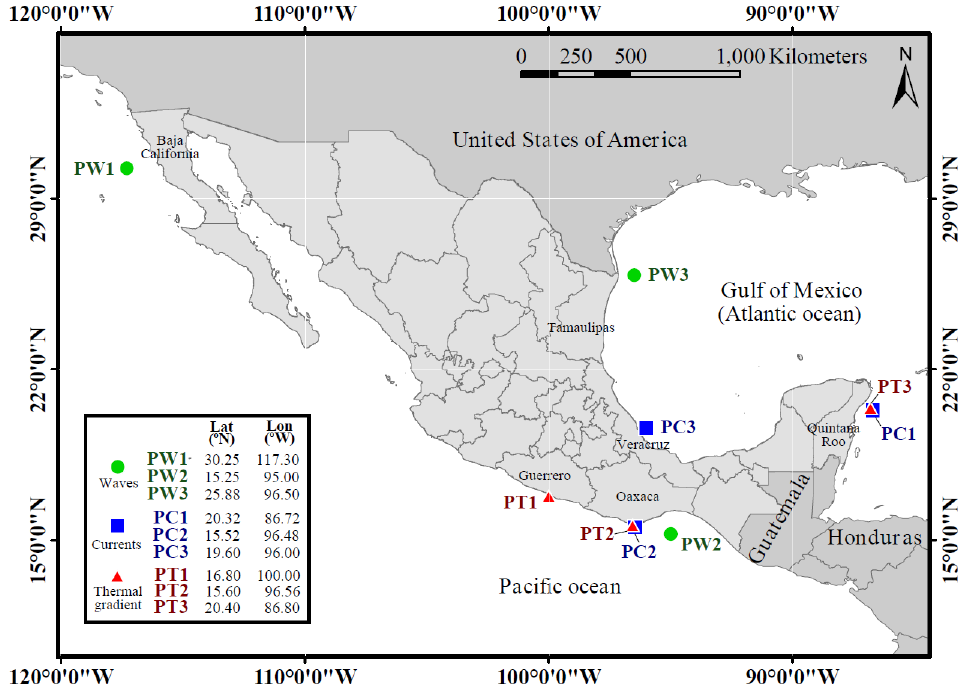
Figure 5. Locations of the sites selected to evaluate the monthly power variations for waves (PW1, PW2, and PW3), currents (PC1, PC2, and PC3), and thermal gradients (PT1, PT2, and PT3).